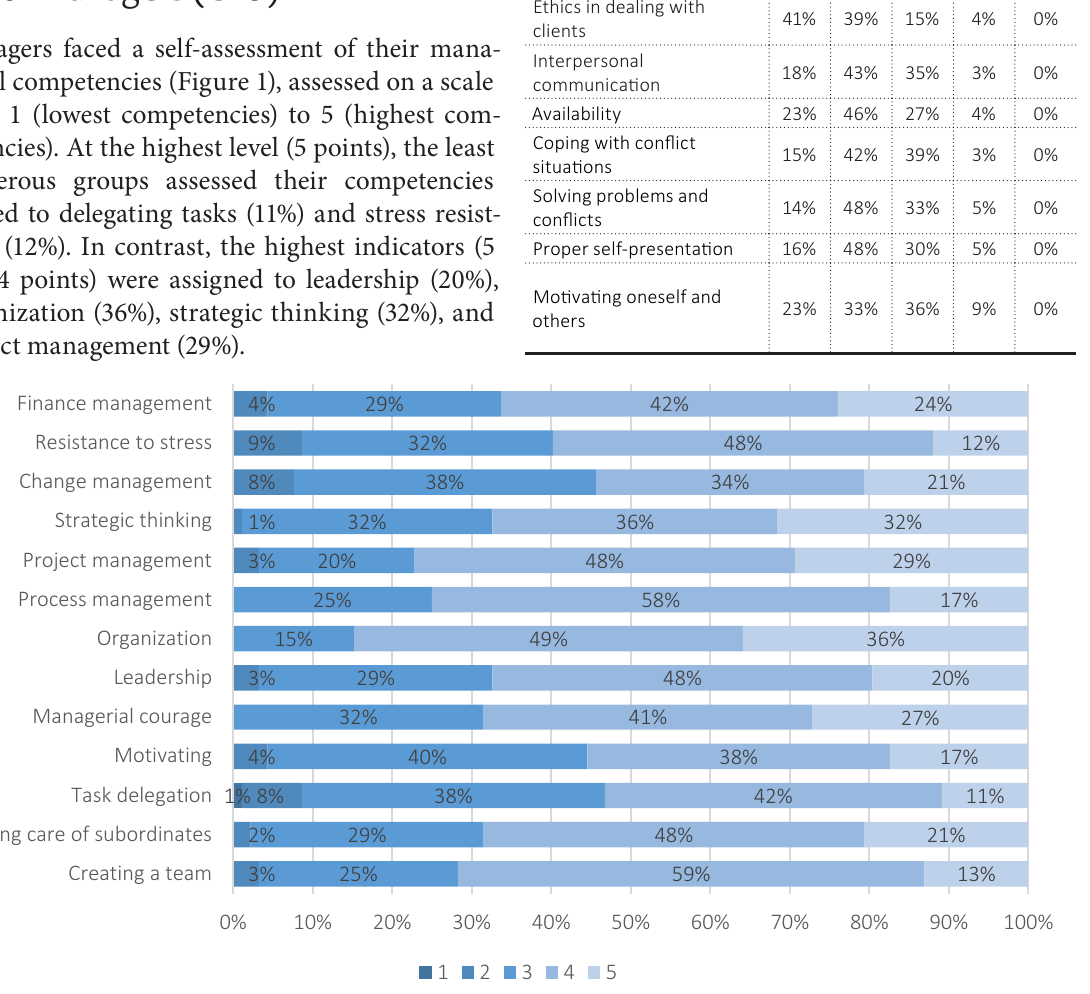
Figure 1. Managerial competencies of the